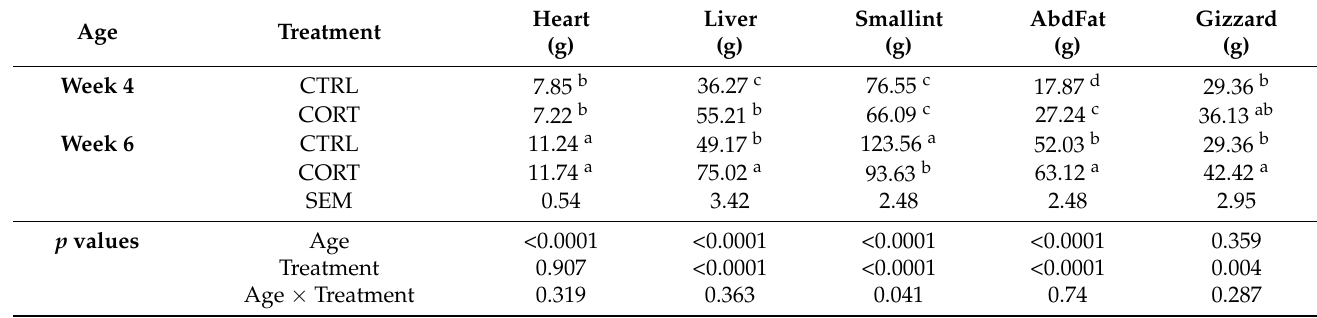
Table 4. Effect of corticosterone feeding and age on absolute organ weight.